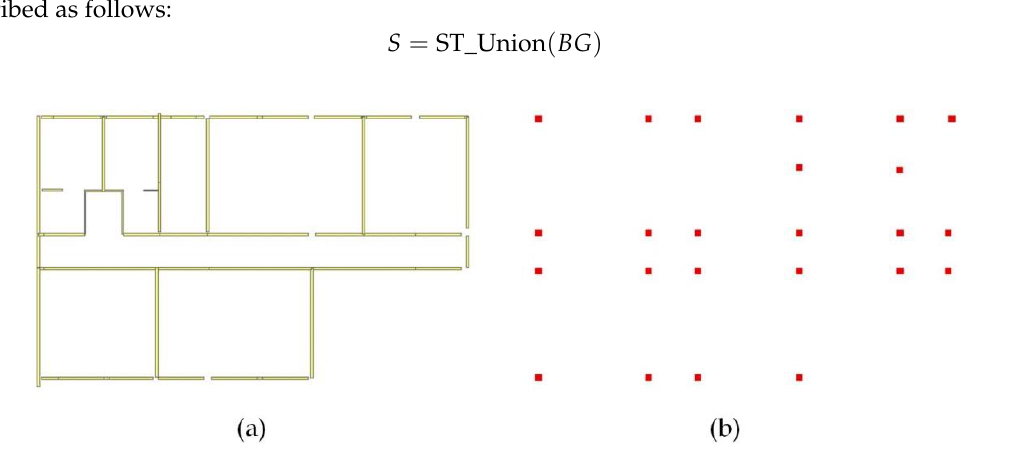
Figure 3. Boundary components: ( a ) walls and ( b ) columns.